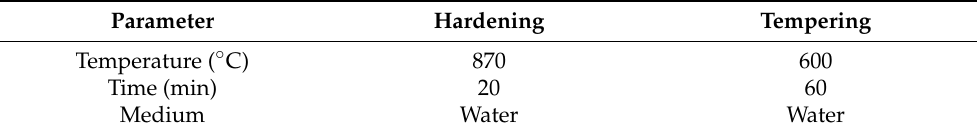
Table 1. Parameters of heat